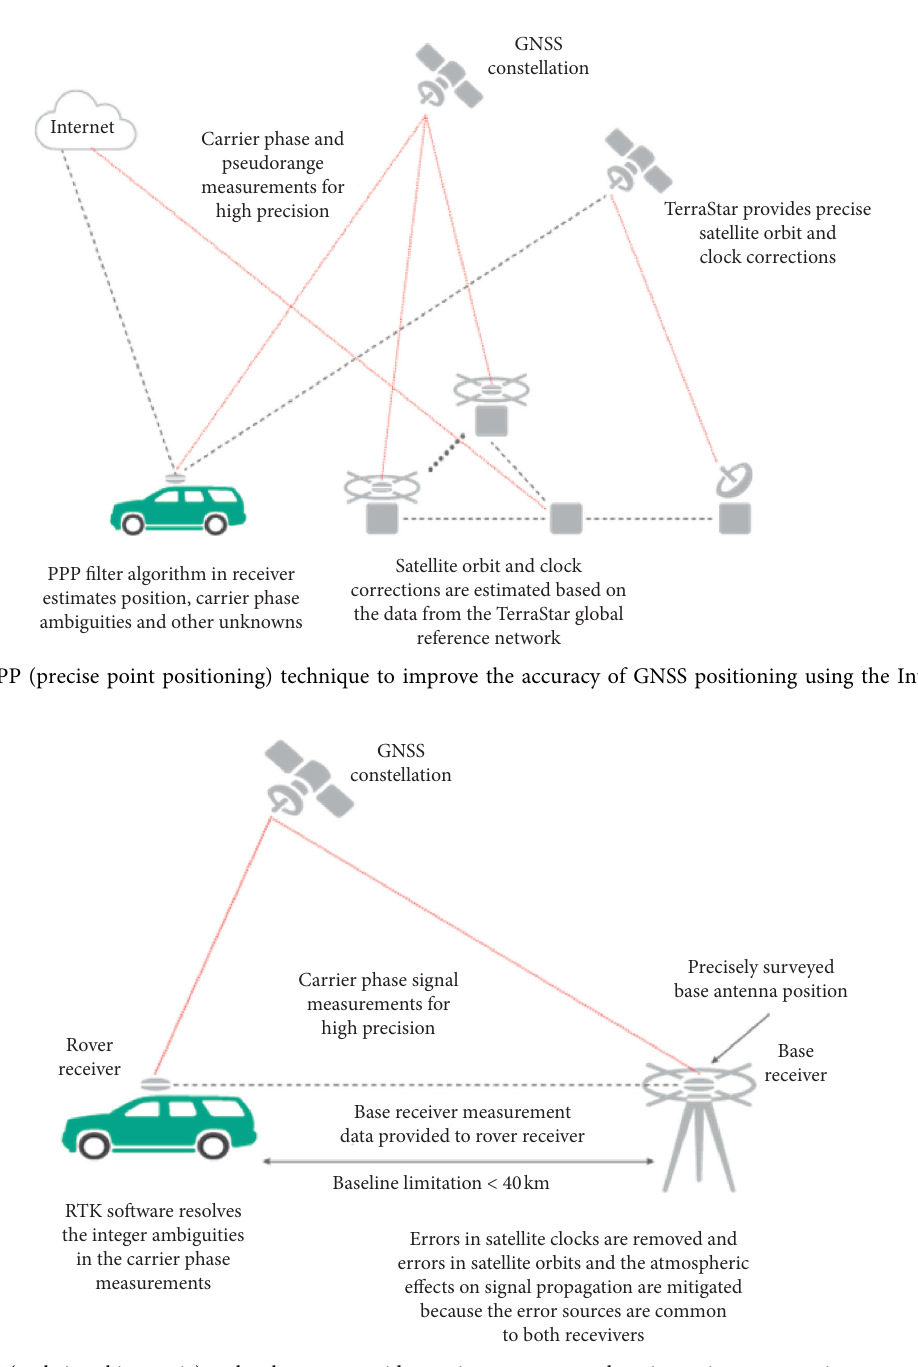
Figure 5: RTK (real-time kinematic) technology to provide centimeter-accurate location using a correcting ground station